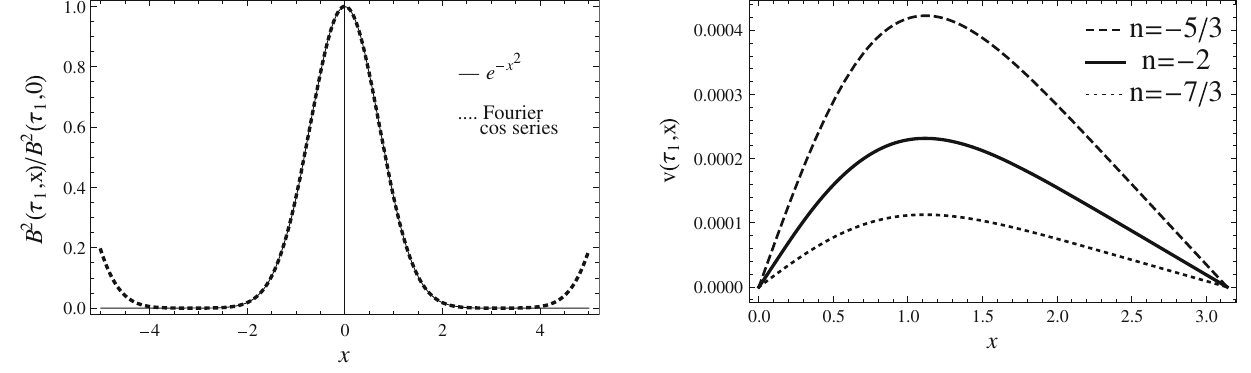
Fig. 3 Transverse velocity v(τ, x ) versus x plotted at the late time τ = 20 fm with different values of n 1